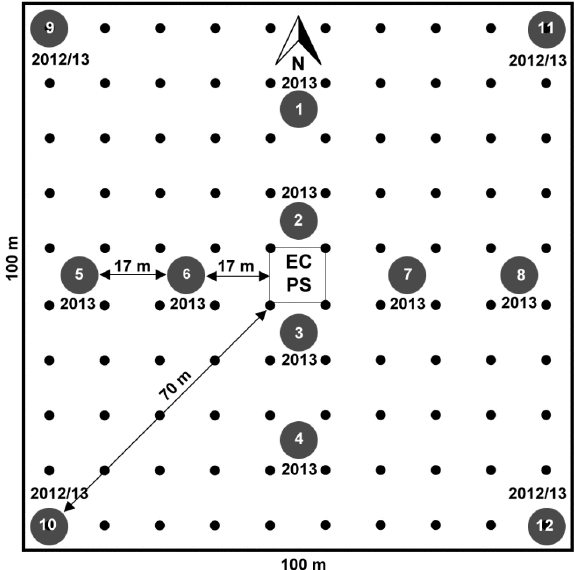
Figure 2. Optical and biomass sampling design around each eddy covariance (EC) and phenology station (PS) location. Canopy-level NDVI 680,800 was sampled at regular intervals within a one hectare region surrounding each flux tower using 10 m grid spacing (approx. 100 samples; sampling locations represented by black dots). Biomass sampling and f APAR green calibration occurred at the locations indicated by numbered circles (1–12), with the sampling years indicated by each circle.